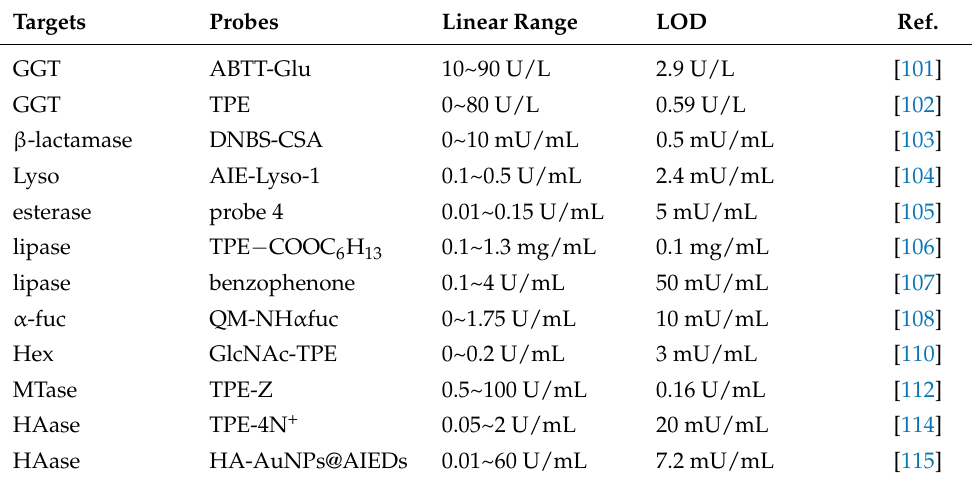
Table 5. Analytical performances of AIE-based methods for the detection of other enzymes.